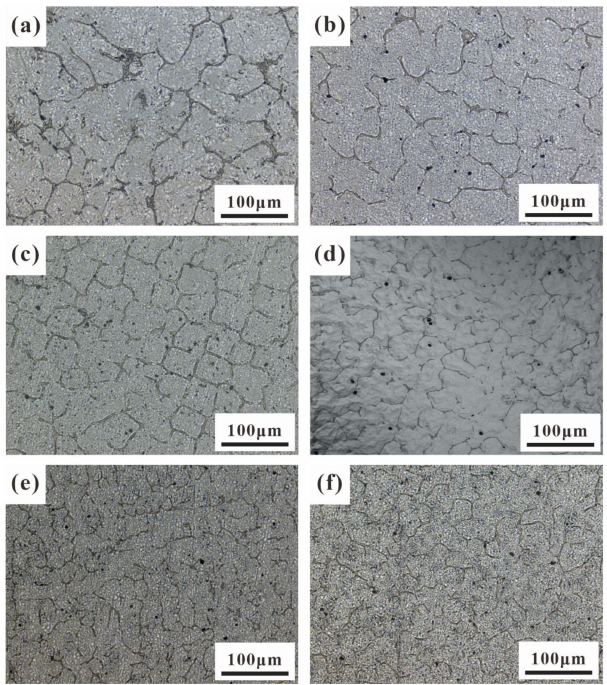
Figure 2. Three-dimensional confocal microstructure of Al 0.6 CrFe 2 Ni 2 HEAs in as-cast and cryo- genically treated states: ( a ) as-cast; ( b ) cryogenic treatment for 4 h; ( c ) cryogenic treatment for 8 h; ( d ) cryogenic treatment for 12 h; ( e ) cryogenic treatment for 24 h; ( f ) cryogenic treatment for 48